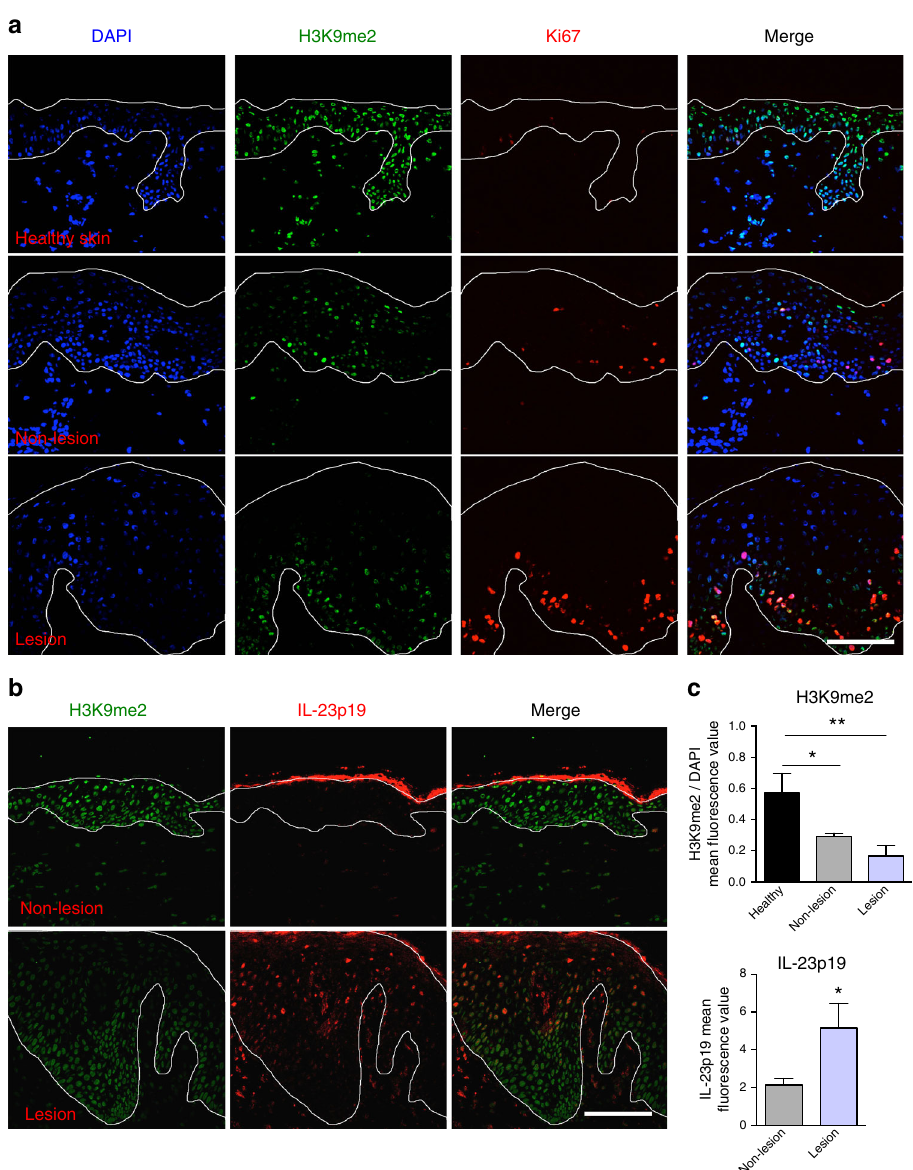
Fig. 10 Decreased H3K9me2 in psoriatic lesions correlating with increased IL-23p19 expression. a , b H3K9me2 staining ( a ) and quanti fi cation ( b ) in healthy skin, non-lesioned and lesioned psoriatic skin ( n : 3/3, mean ± SD, one-way ANOVA, with Tukey ’ s multiple comparisons). c H3K9me2 and IL-23p19 staining in non-lesioned and lesioned psoriatic skin ( n : 3/3). Scale bars: 100 µ m ( a , c ). (* p ≤ = 0.05; ** p ≤ = cell strainer (40 μ m). To promote IL-17 expression and prevent secretion, cells were fi rst stimulated for 6h in RPMI containing cell stimulation cocktail plus protein transport inhibitors (00-4975-93, eBioscience, USA) at 37°C. The cell suspension was then stained for surface markers for 20min on ice in the dark, fi xed with 4% paraformaldehyde for 10min at room temperature, permeabilized with 0.1% Triton X-100 on ice for 2 min, blocked with blocking buffer on ice for 10 min and stained for intracellular markers. Data were collected by FACS Calibur (BD Biosciences, USA) using the CellQuestPro software and analyzed by Flowjo 8.8.2. The following antibodies were used: CD45.2-FITC (11-0454, 1:100 dilution), CD4- FITC (11-0041, 1:100 dilution), TCR γ – FITC (11-5711, 1:100 dilution), IL-17a-APC (17-7177-81, all eBioscience, USA, 1:100 dilution), TNFRI-PE (113003, 1:100 dilution), and CD3 ε -CY5.5 (100328, 1:100 dilution, all BioLegend, USA).